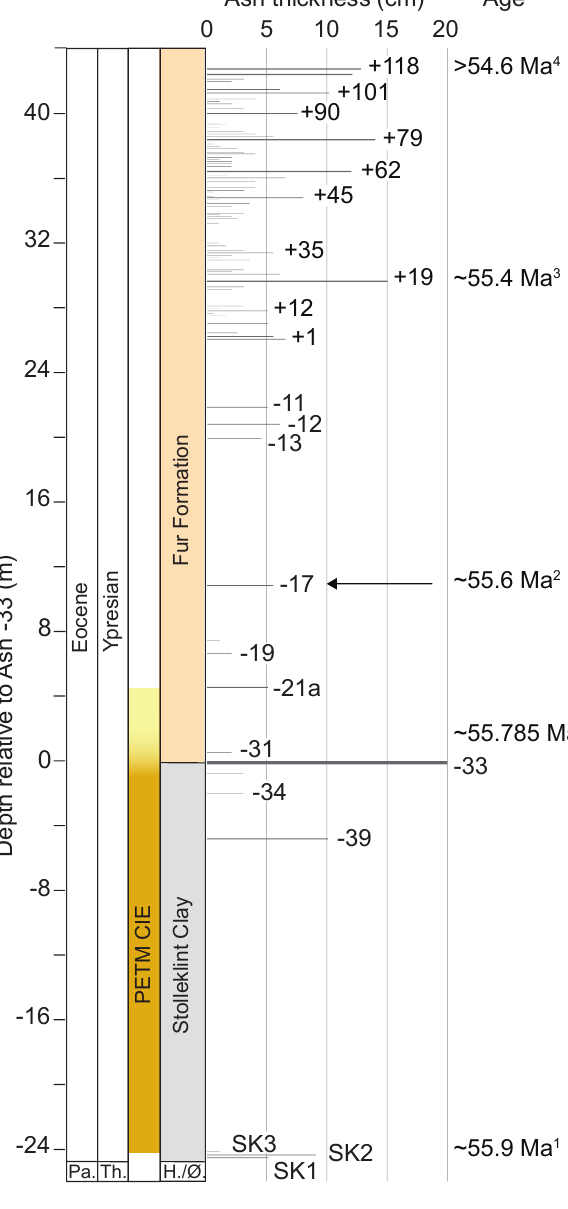
Figure 5: The relevant stratigraphy at Stolleklint and Knudeklint (locations shown in Figure 2). Pa. = Pale- ocene; Th. = Thanetian; H./Ø. = Holmehus/Østerrende Formation. For additional lithological information, see Stokke et al. [2020]. Extent of PETM carbon isotope excursion (CIE) taken from Stokke et al. [2020]. Grey lines indicate ash layers, with main ash layers labelled and maximum ash layer thickness measured at Fur in- dicated on the top. Note that there are some thickness variations within Denmark [Bøggild 1918]. 1